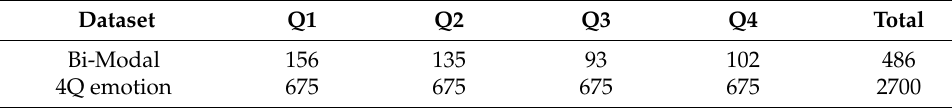
Table 3. The amount of data on Bi-Modal and 4Q emotion dataset.